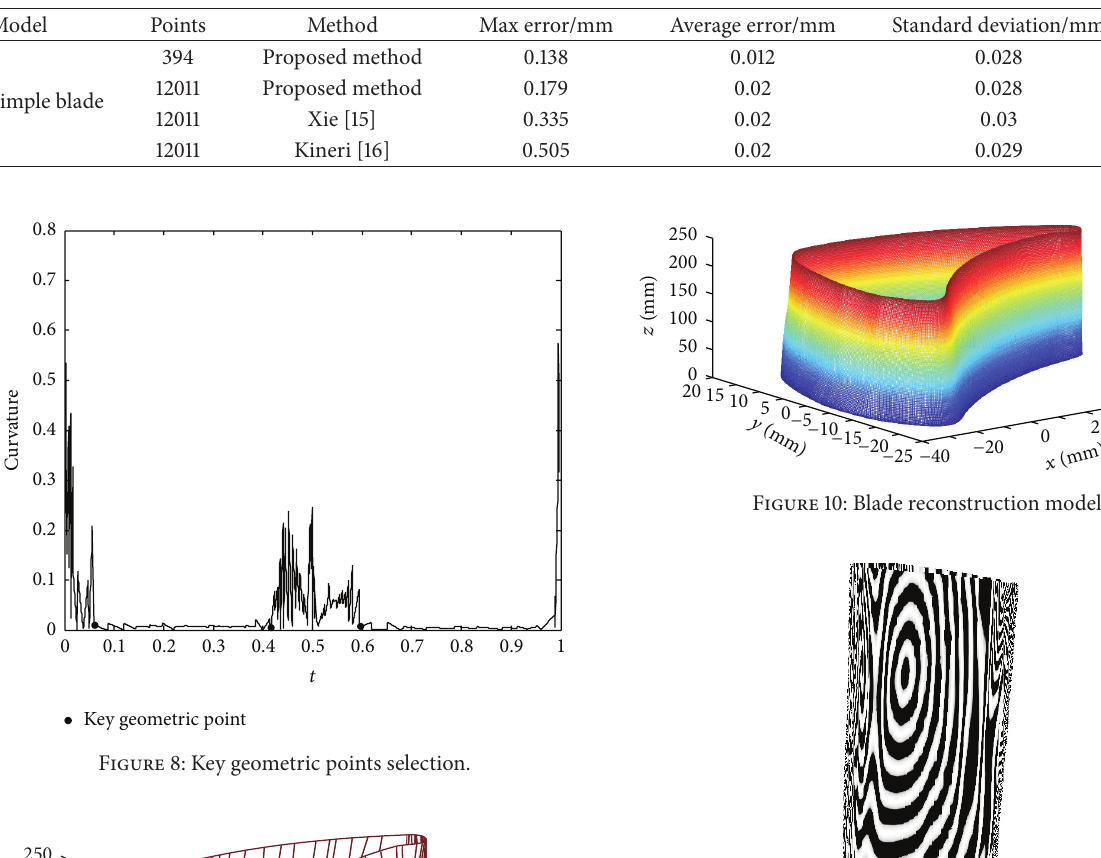
Table 1: Comparison results of multialgorithms for simple blade.